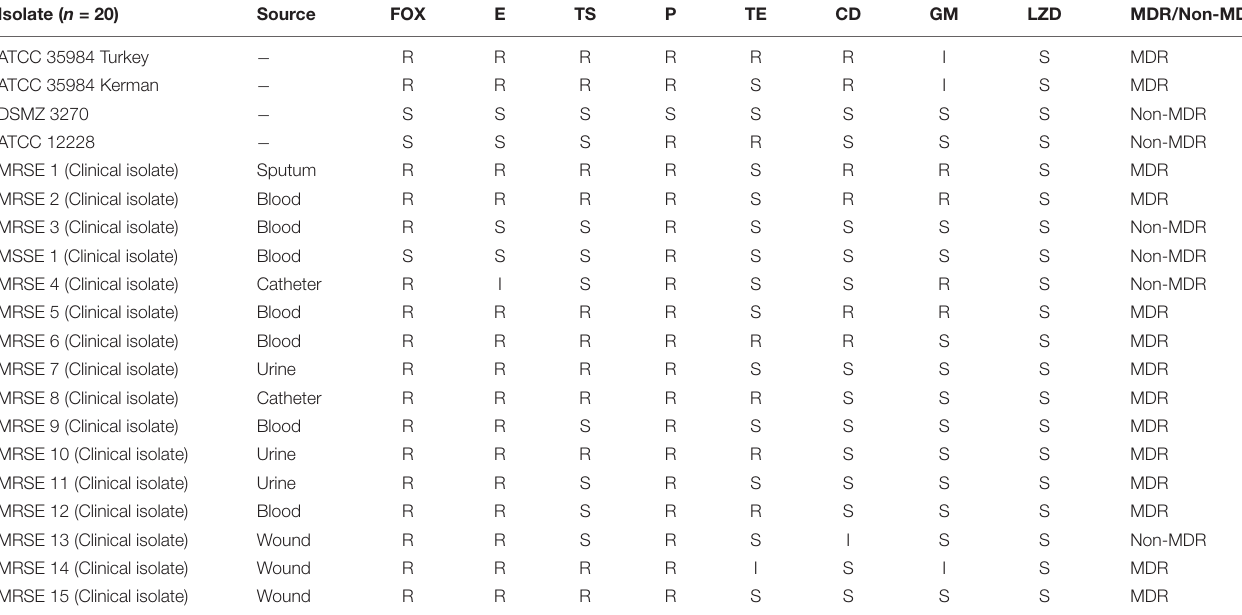
TABLE 1 | Antimicrobial susceptibility test in Staphylococcus epidermidis isolates. Isolate ( n =